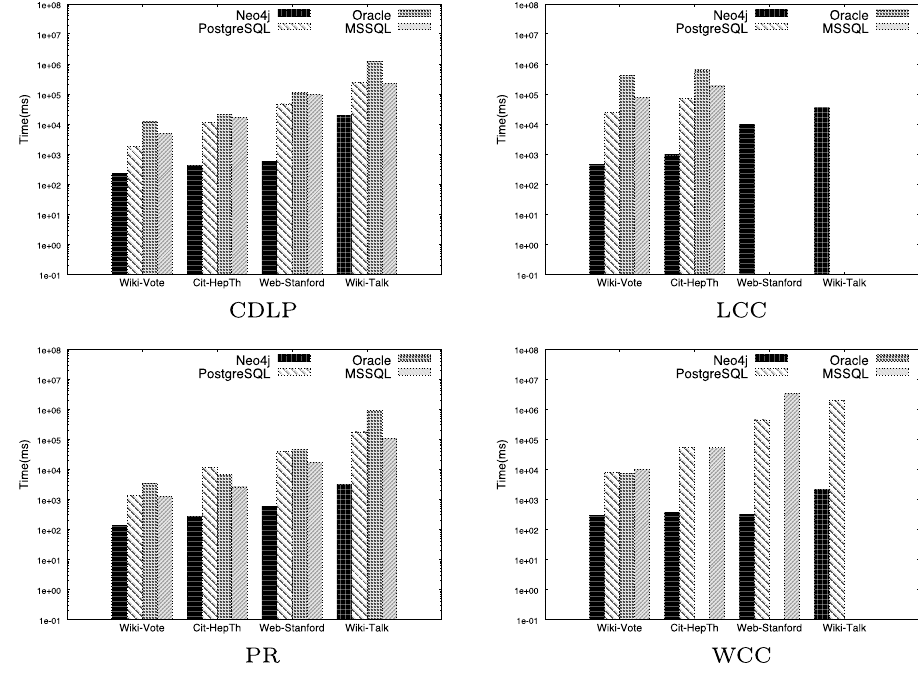
Fig. 9 Testing 4 graph algo- rithms over 4